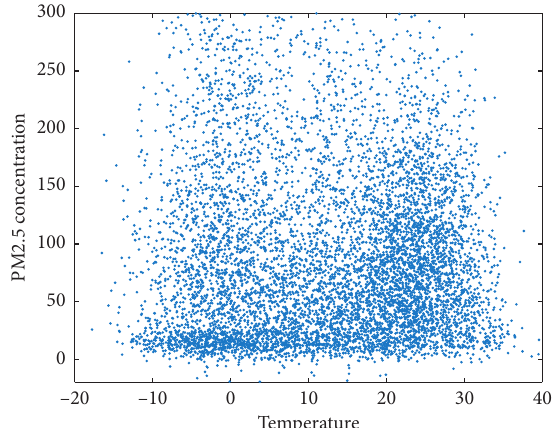
Figure 7: Phase portrait of temperature vs. PM2.5 concentration.